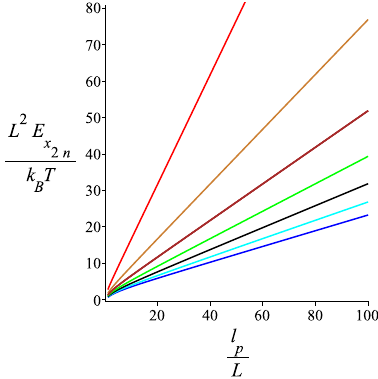
Figure 13. The dimensionless tensile stiffness of the grafted kinked structure with an even number of arms as a function of the dimensionless persistence length of a single arm. The red, gold, brown, green, black, cyan, and blue correspond to fixed values of the parameter n = 1,2,3,4,5,6,7, respectively. n = 2, and K B = The other fixed parameters are: ω = π , φ µ = 0, φ B = π 9 4